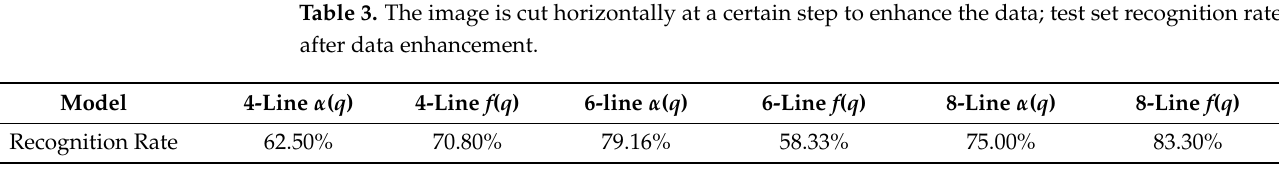
Table 3. The image is cut horizontally at a certain step to enhance the data; test set recognition rate after data enhancement .